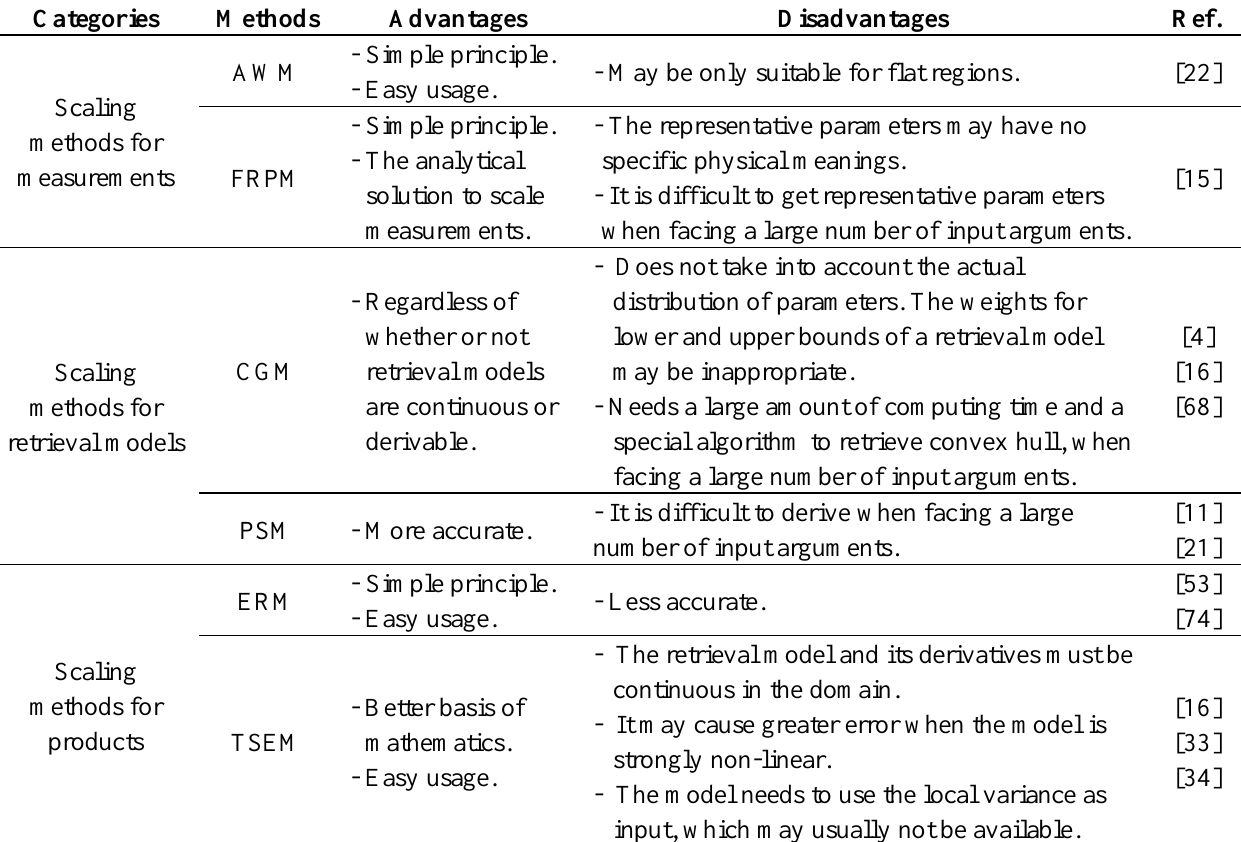
Table 3. Summaries of general scaling methods used in remote